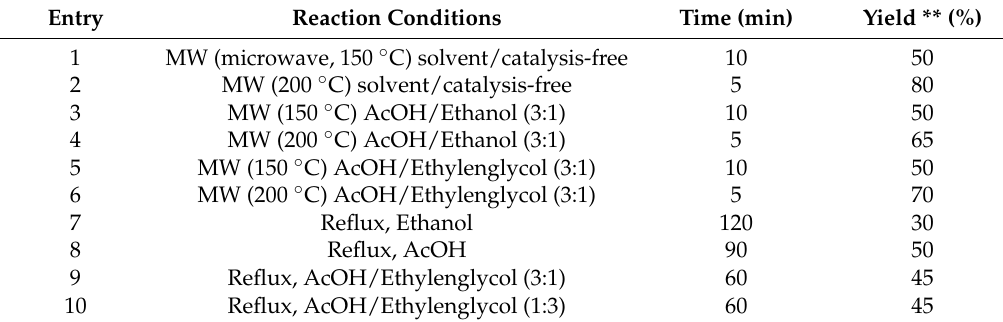
Table 1. Evaluation of the parameters of the multicomponent reaction (MCR) of compound 4a . * Entry